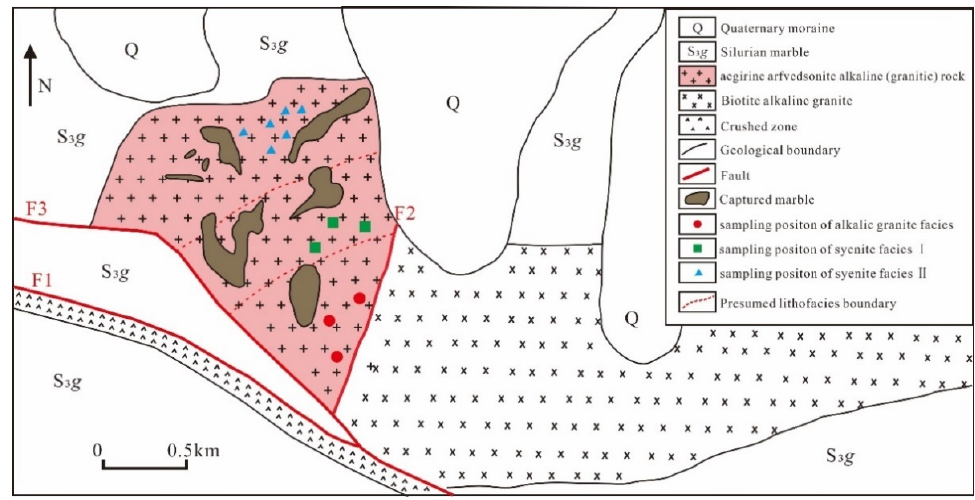
Figure 2. Simplified geologic map of the Boziguoer intrusion and sample locations (modified after [28,29]).